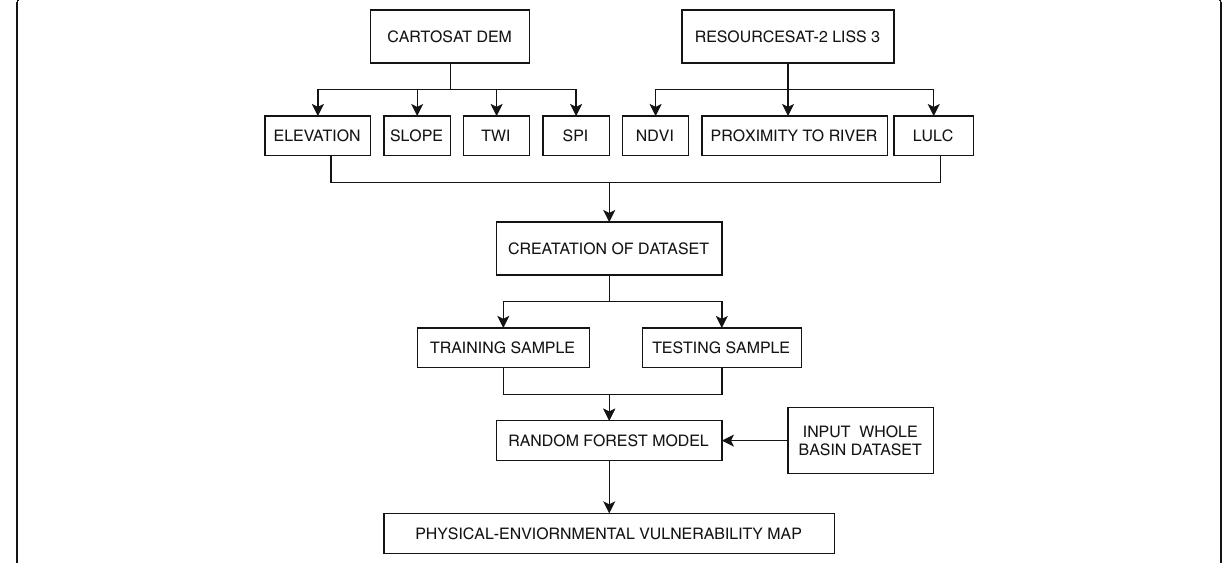
Fig. 3 Methodology for physical-environmental